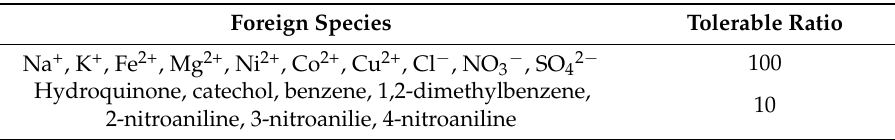
Table 2. Effects of foreign species on the determination of 4-NP.